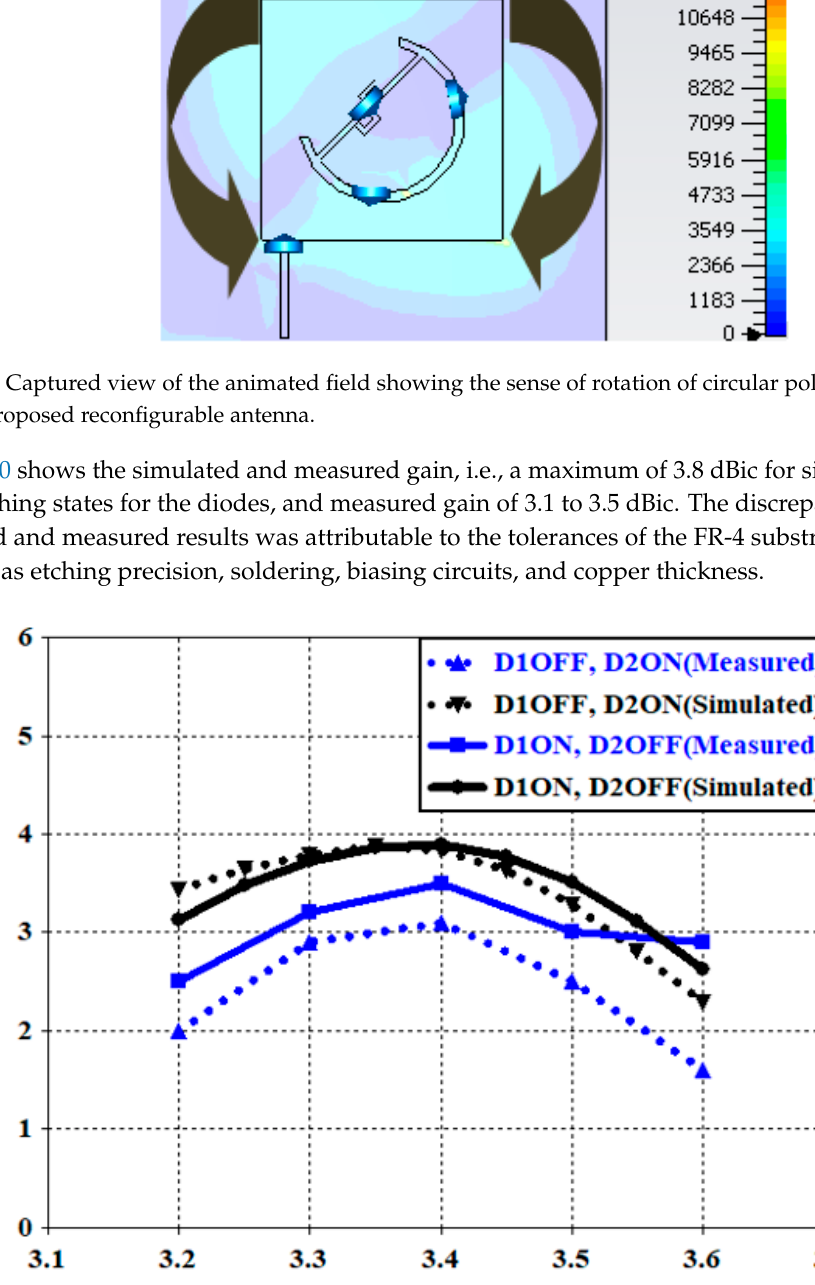
Figure 10. Measurement and simulation results for maximum gain for the proposed reconfigurable antenna.